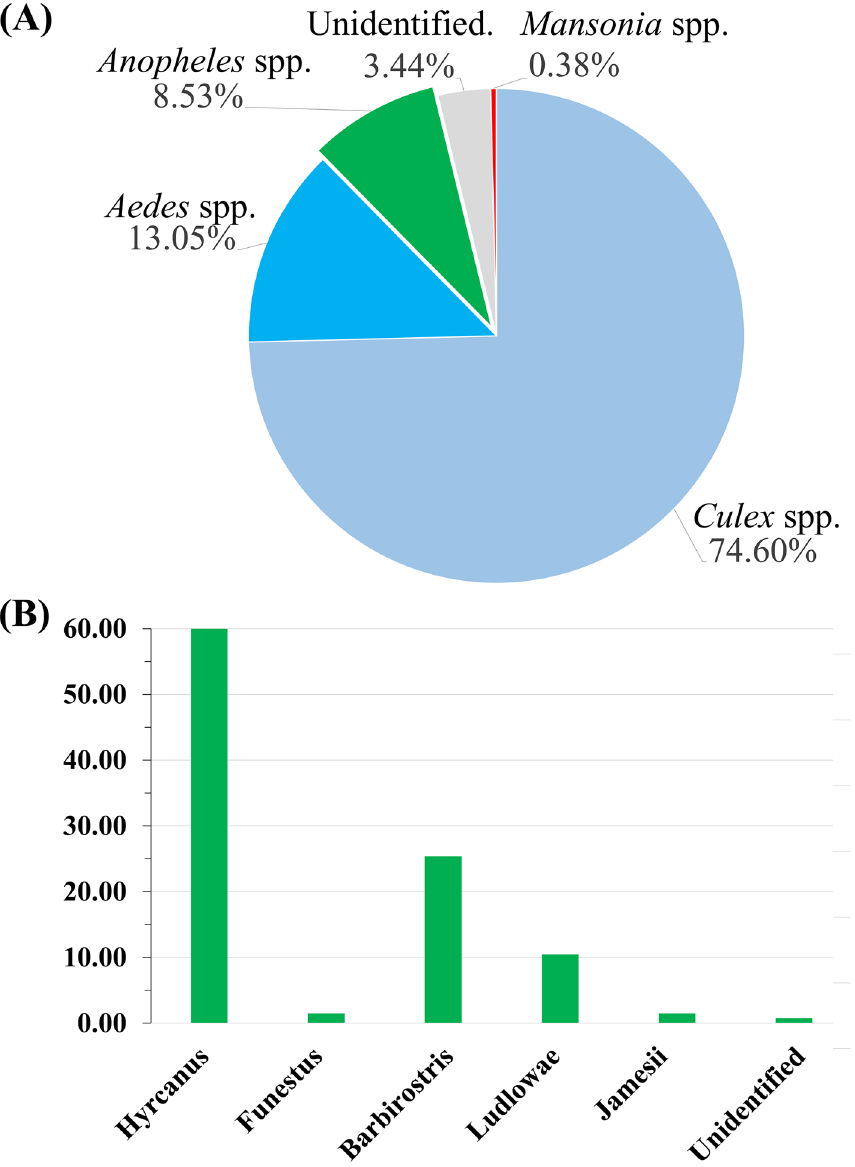
Figure 1. Chart illustrating the percentage of mosquitoes, according to morphological identification. ( A ) Percentages of each genus of mosquitoes collected in this study. ( B ) Anopheles mosquito groups.